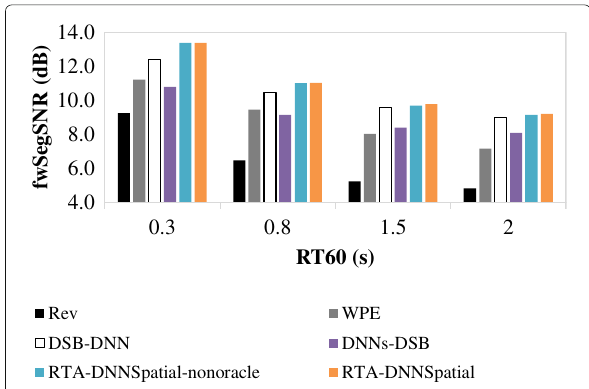
Fig. 13 Average fwSegSNR results at different RT60s, tested with an RT60